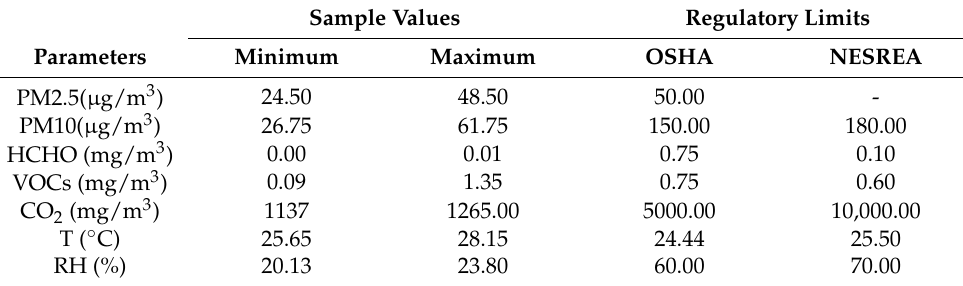
Table 4. The AQ Parameters and Permissible Exposure Limits (8 h